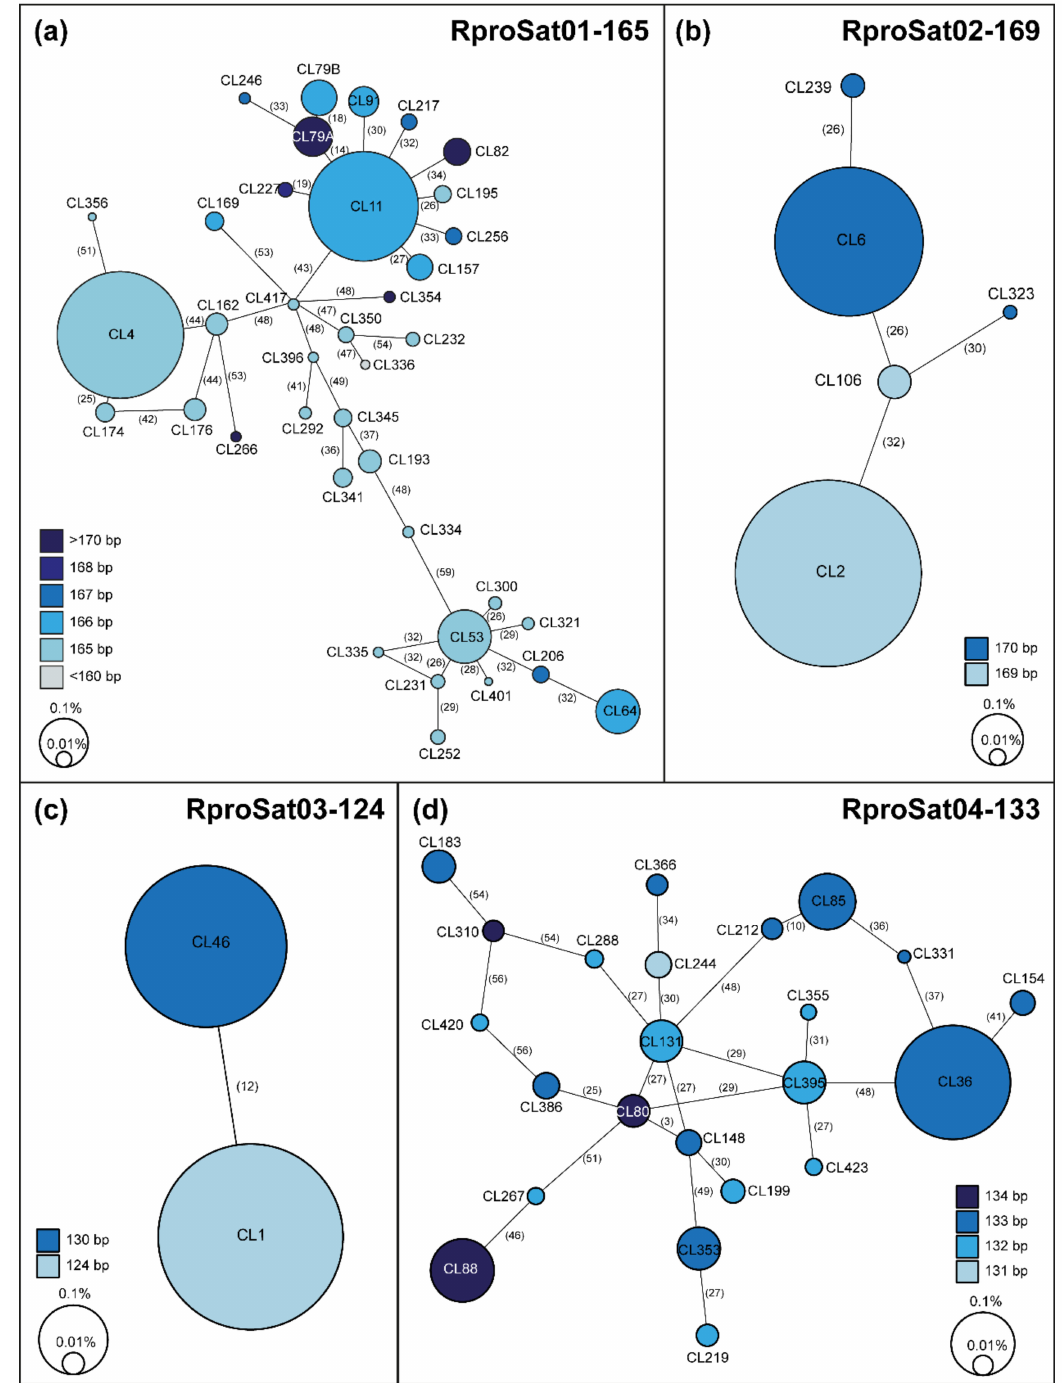
Figure 5. Minimum spanning networks for the four satDNA families forming superclusters in Rhodnius prolixus : ( a ) RproSat01-165, ( b ) RproSat02-169, ( c ) RproSat03-124 and ( d ) RproSat04-133. Numbers between brackets are the mu- tational steps. Each circle corresponds to a RepeatExplorer2 cluster or subfamily, where the size is proportional to its abundance in the genome. Colors denote the consensus monomer